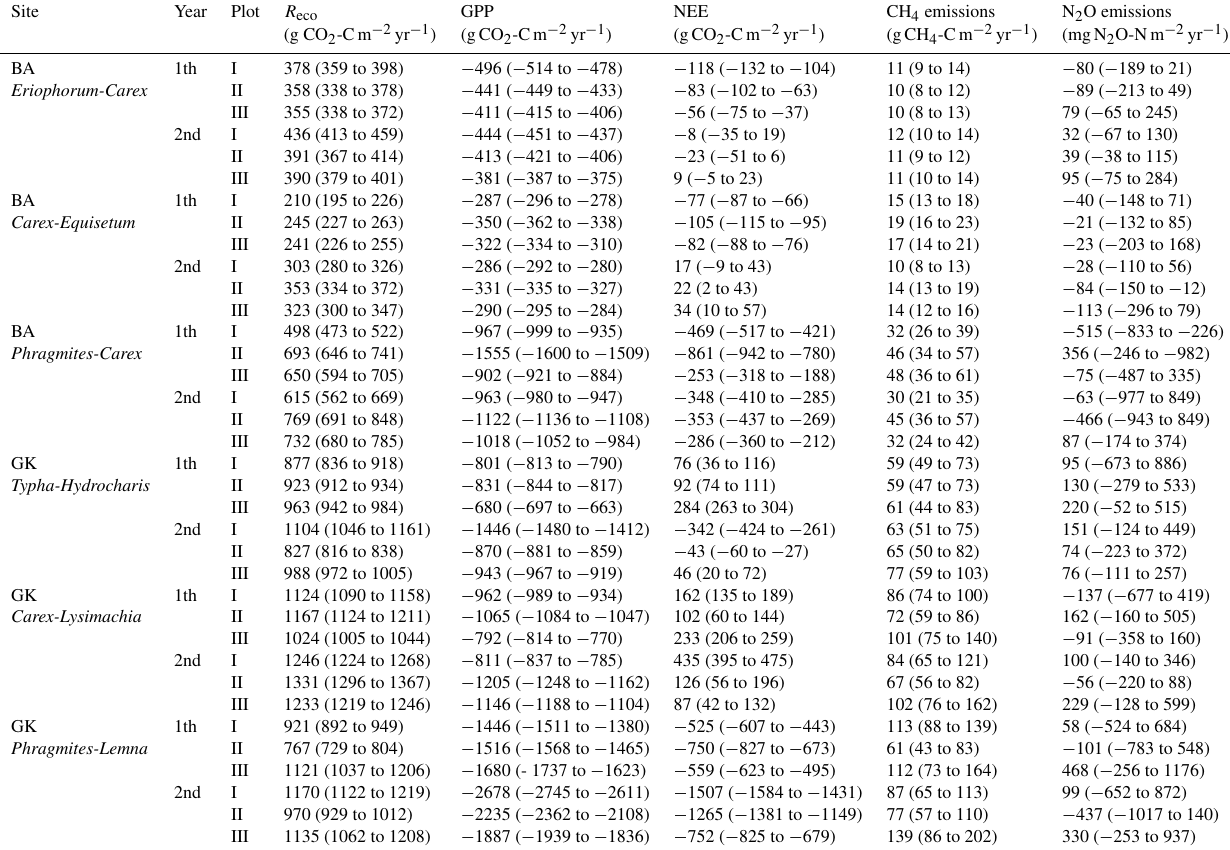
Table A3. Annual fluxes of CO 2 , CH 4 , and N 2 O with confidence intervals